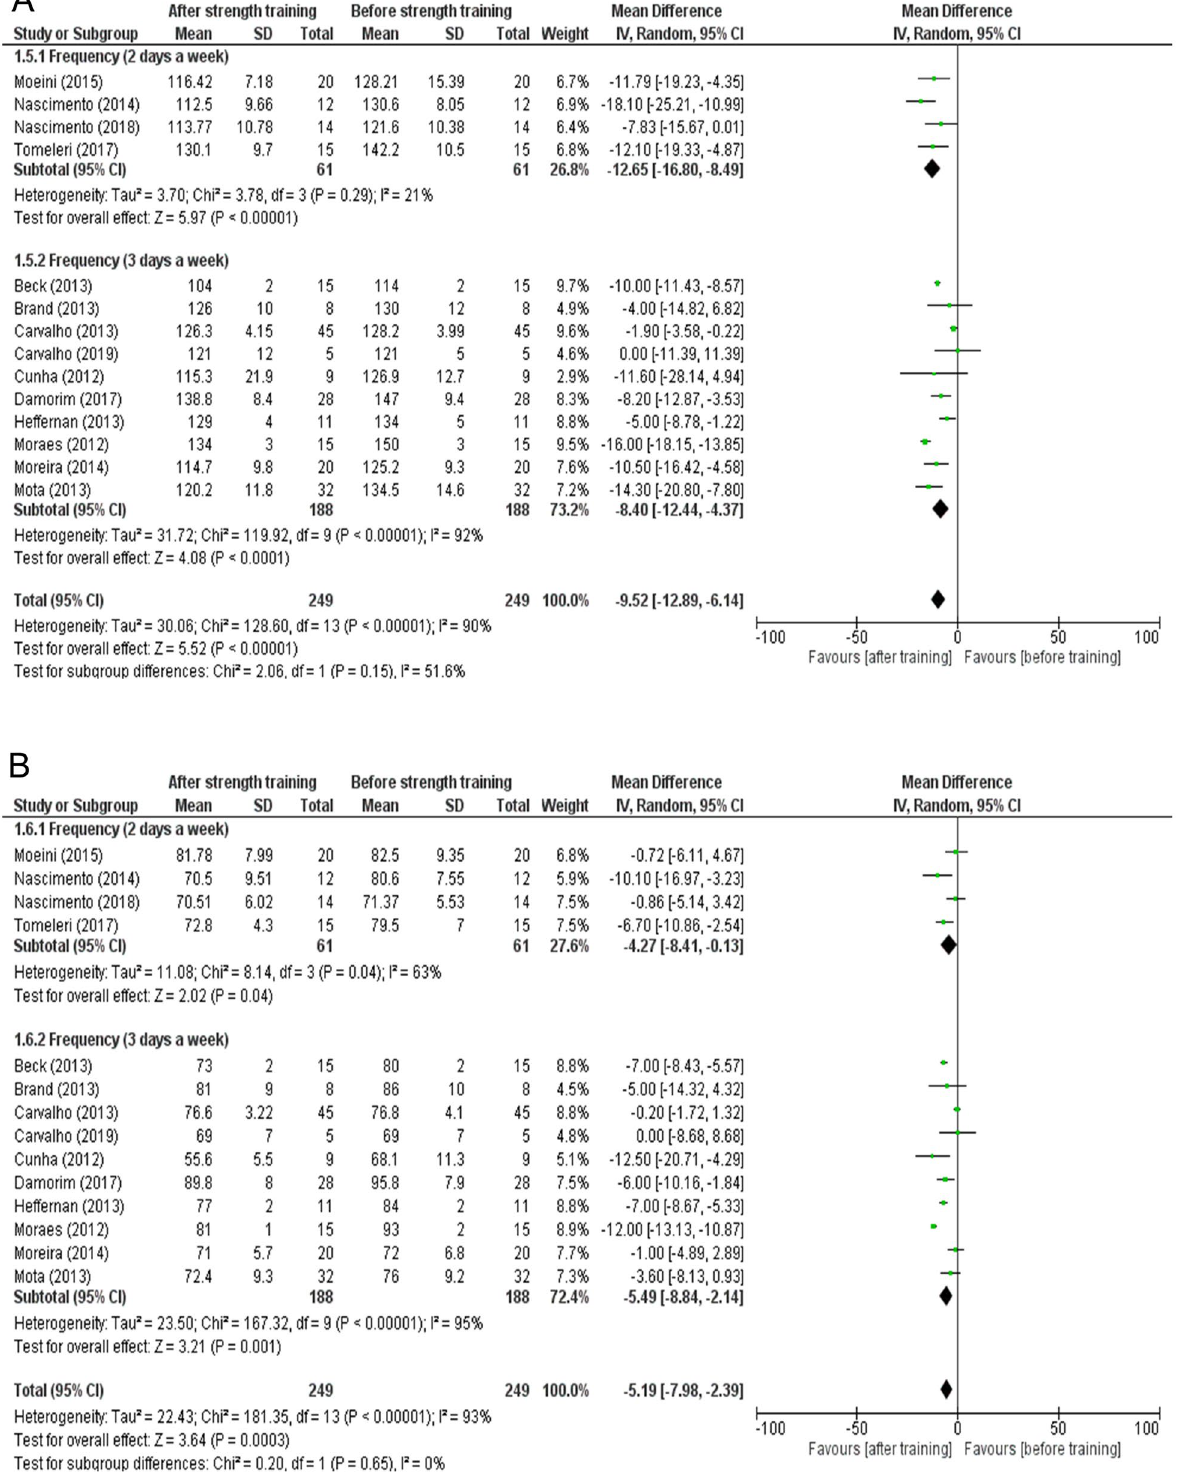
Figure 5. ( A ) Effects of strength training on systolic blood pressure in hypertensive individuals with 2 and 3 days a week of training frequency. ( B ) Effects of strength training on diastolic blood pressure in hypertensive individuals with 2 and 3 days a week of training